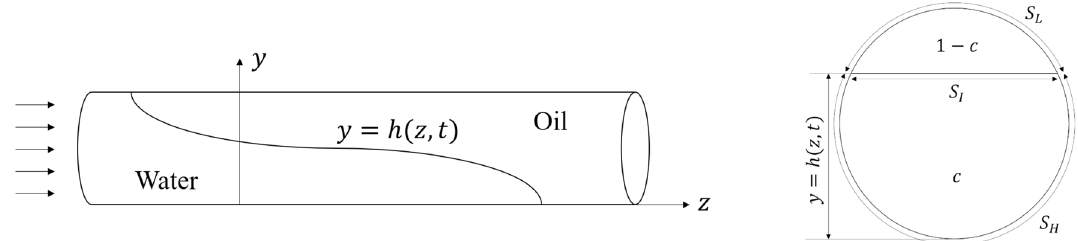
Figure 4. Schematic showing the assumed fluid configuration during displacement, where the density difference between the fluids results in a stratified interface, defined by a single-valued function y where y is in the vertical direction and z is parallel to the pipe axis. In a cross-sectional plane through the pipe, water occupies a fraction c of the cross-section, and wets a perimeter S H of the pipe. The lighter oil occupies the c fraction of the cross-section and wets a perimeter S L . The interface between the fluids is assumed upper 1 − horizontal within the cross-sectional plane, and of length S I